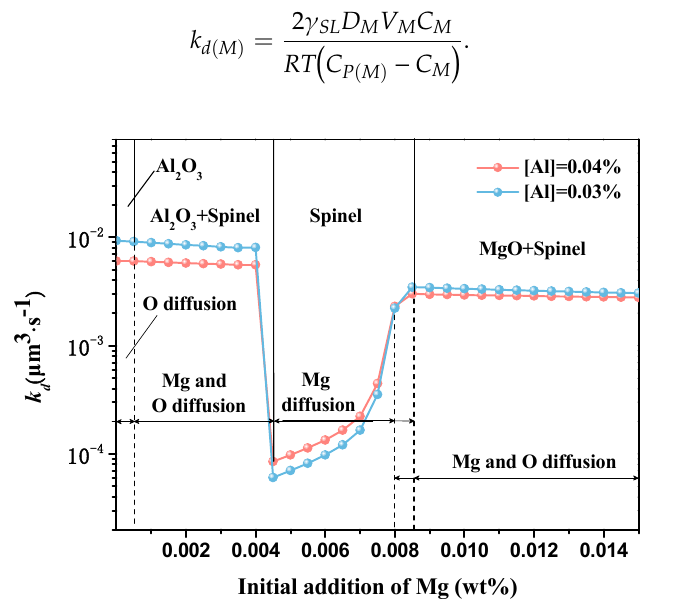
Figure 7. Effect of Mg addition on coarsening rate caused by Ostwald ripening k d of inclusions.